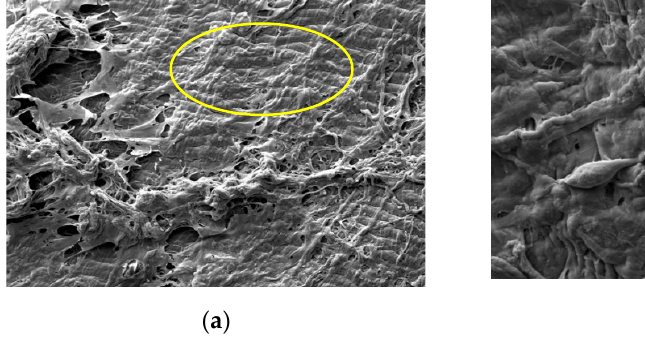
Figure 4. Cell decalcification detection: ( a ) SEM image before the treatment; ( b ) SEM image after the treatment; and ( c ) ARS assay before the treatment (white bar) and after the treatment (black bar).